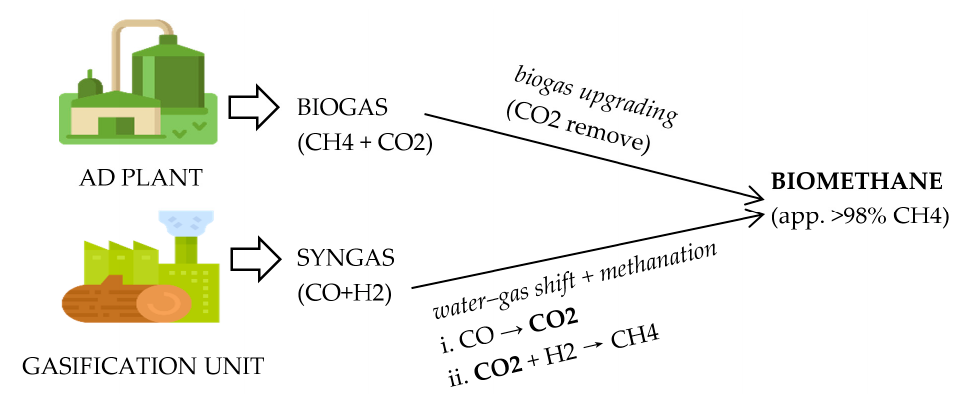
Figure 1. Biomethane production pathways. Source: own elaboration based on [10,13]. According to the International Energy Agency (IEA) data [10], in 2019, 90% of bio- methane produced worldwide was obtained due to the biogas upgrading process. However, biomethane can also be obtained through biomass gasification followed by syngas metha- nation or conversion of biomass-derived CO 2 with H 2 into CH 4 (bio methanation